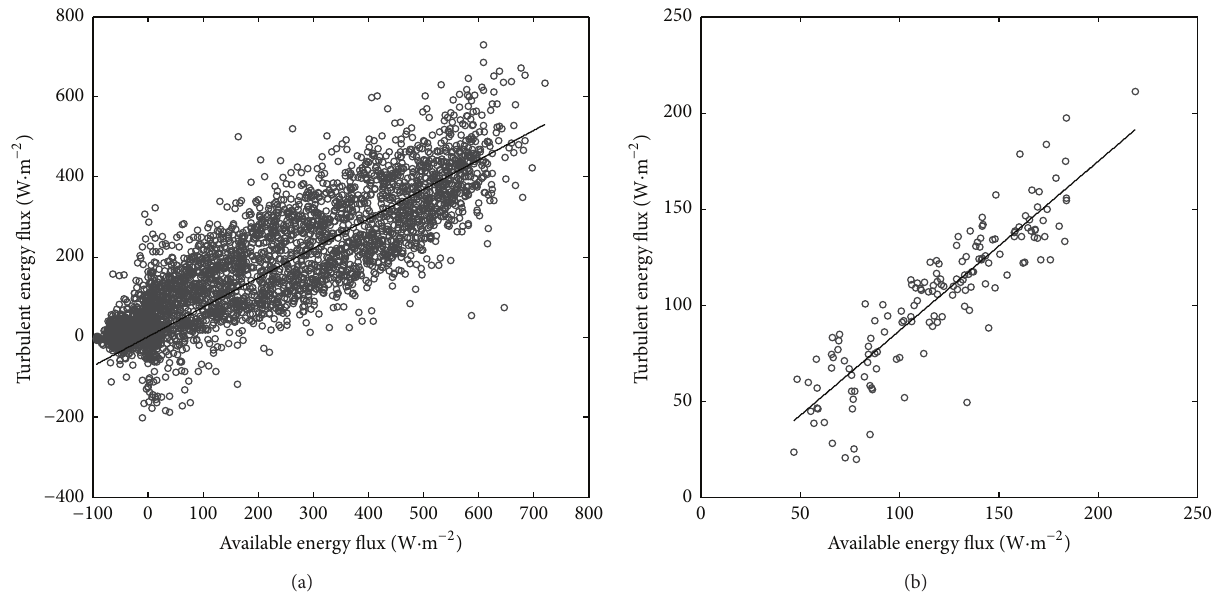
Figure 2: Relationship between the turbulent energy flux and available energy flux ((a) 30-minute data; (b) daily data).